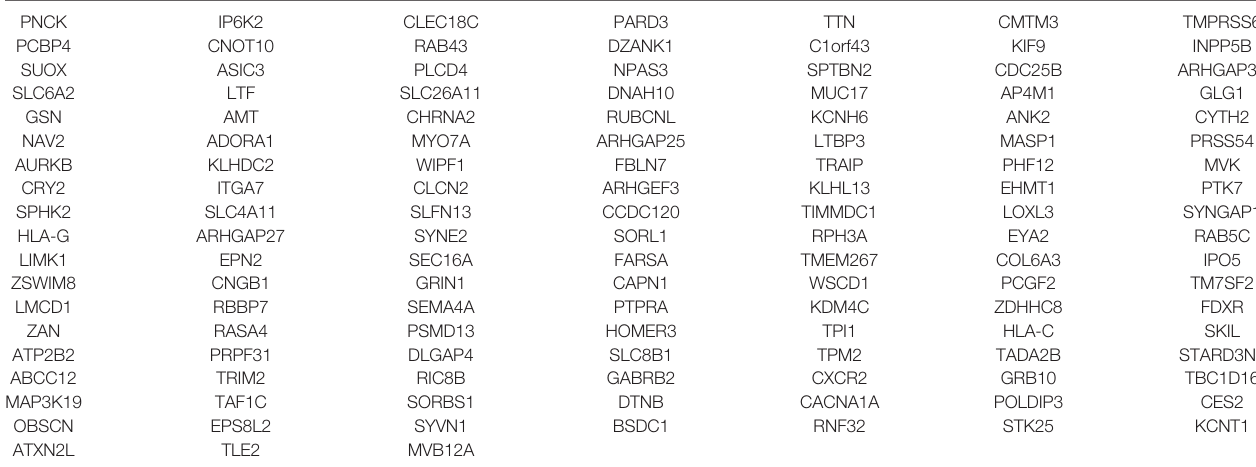
TABLE 3 | Predict Driver Genes in Three FLC Patients.